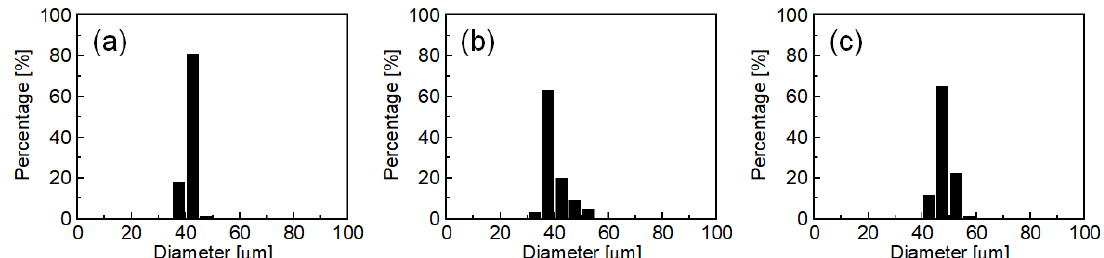
Figure 2. Number-weighted droplet diameter distributions of oil-in-water (O/W) emulsions obtained by MC emulsification at 60 °C with MC-A using ( a ) SDS, ( b ) HGML, and ( c ) SC as emulsifiers. Each histogram contains the data on diameter for more than 100 droplets.